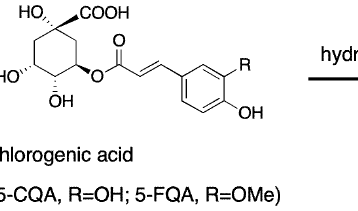
Figure 2. The metabolism of chlorogenic